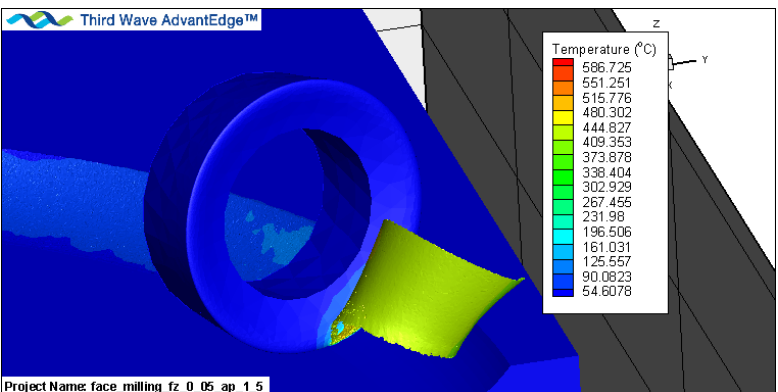
Figure 4. FEM analysis of chip formation.